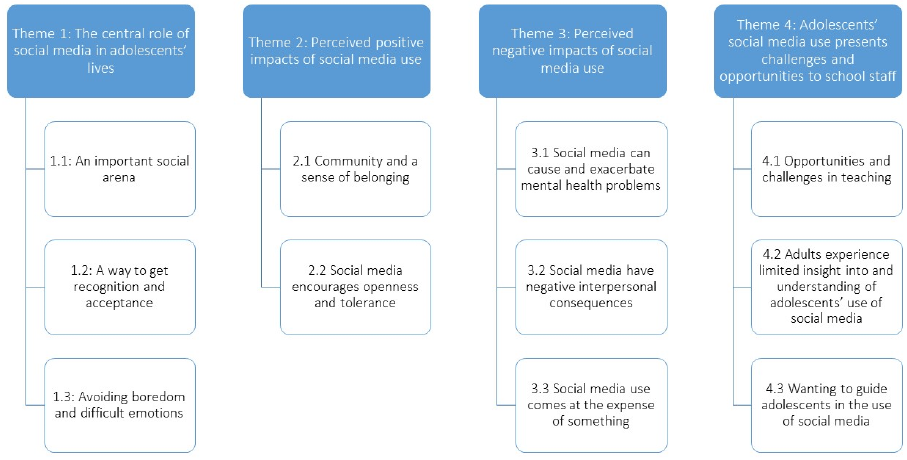
Figure 1. Overview of themes and sub-themes.